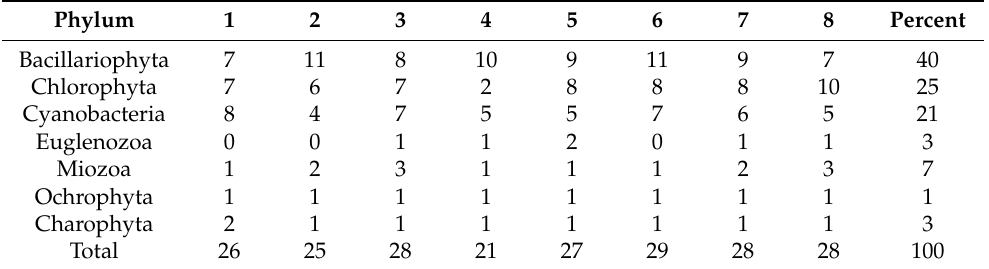
Table 1. Species richness of phytoplanktonic algae and cyanobacteria in Lake Borovoe, summer 2019.